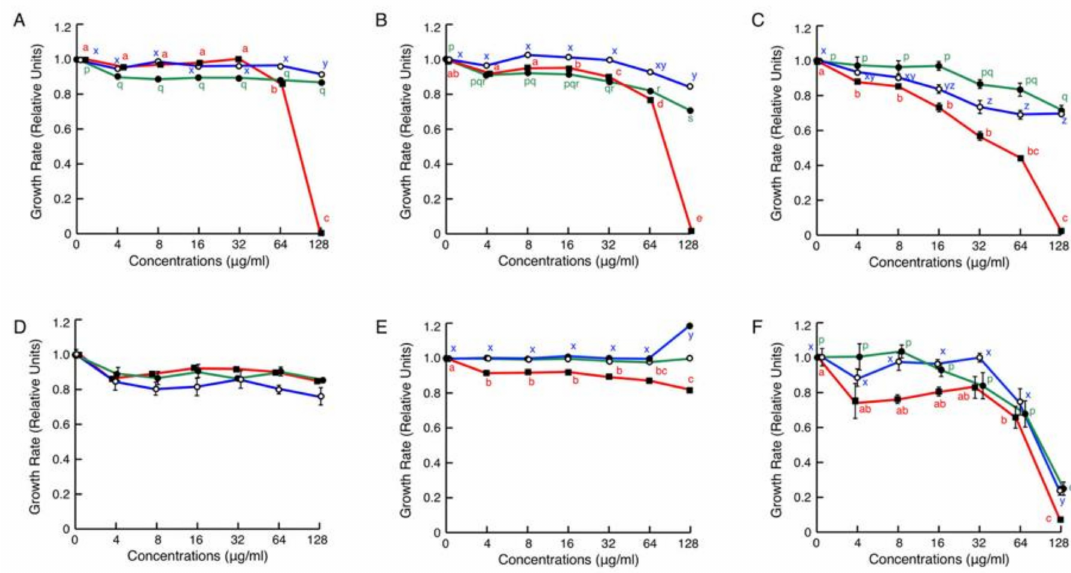
Figure 3. E ff ects of various concentrations of synthetic brevinin-2SSb (red lines), ranatuerin-2SSa (green lines), and granuliberin-SSa (blue lines) on the growth of animal pathogenic Gram-negative bacteria ( A – C ), Gram-positive bacteria ( D , E ), and the fungus ( F ). Cells of Escherichia coli ( A ), Salmonella enterica ( B ), Pseudomonas aeruginosa ( C ), Staphylococcus aureus ( D ), Bacillus cereus ( E ), or Candida albicans ( F ) were incubated with serially diluted brevinin-2SSb, ranatuerin-2SSa, or granuliberin-SSa for 20 h at 35 ◦ C. Points and vertical bars represent means and standard error of the mean (SEM), respectively (n = 4). In all panels except ( D ), values with the same letters are not significantly di ff erent ( p ≥ 0.05). The G. susurra peptides were not active against the Gram-positive bacterial